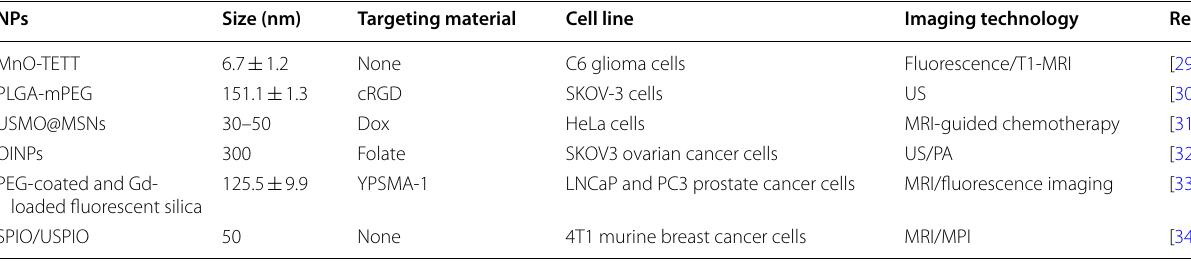
Table 2 Typical NPs platforms made by different materials for medical